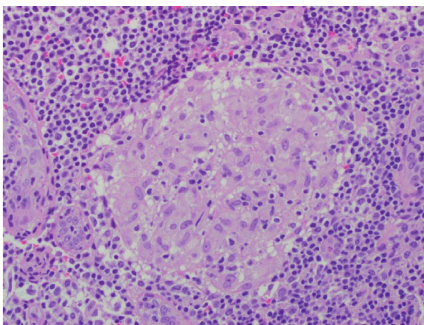
Figure 6: Histopathology showing noncaseating granulomas.